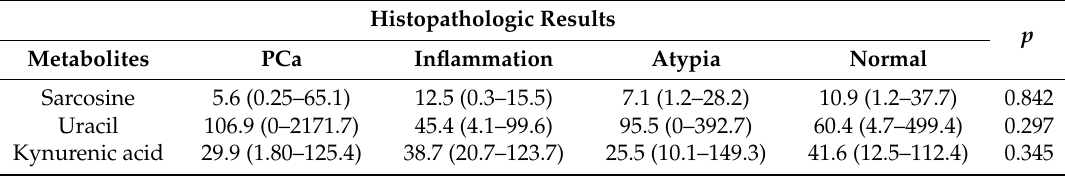
Table 4. Endogenous metabolites in urine according to histopathologic results—group A + B. Values are presented as medians/ranges in mg/L.